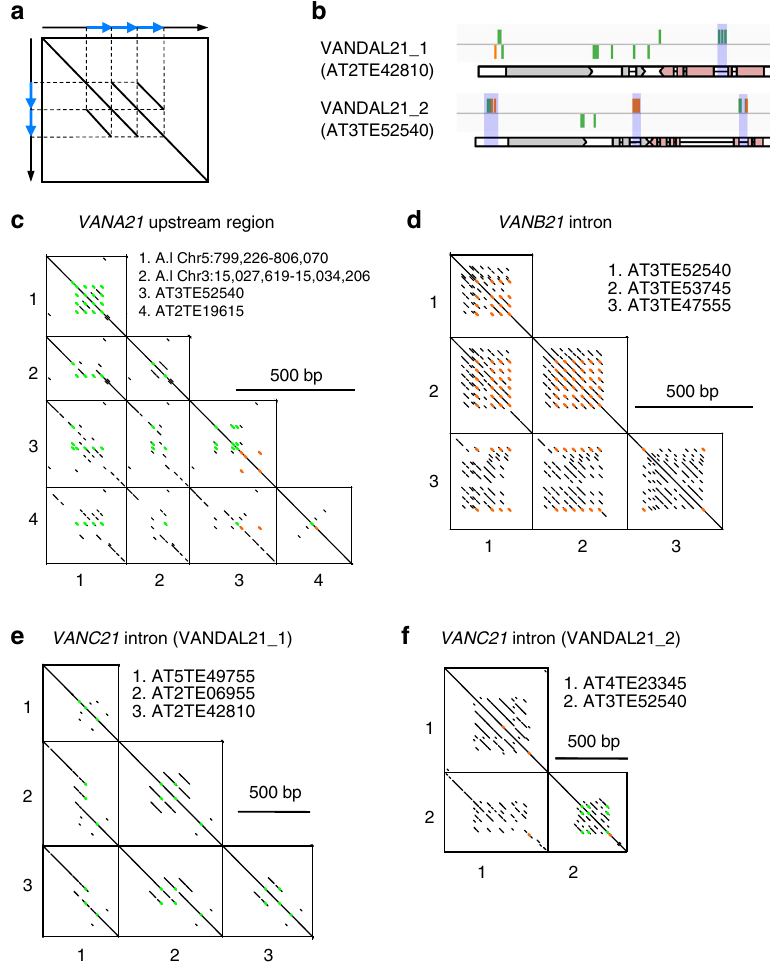
Fig. 4 Evolution of VANC21-binding regions. a Schematic diagram of dot plot for sequences with tandem repeat structures. Blue arrows indicate tandem repeats. Because of sequence identity, tandem repeat structure generates parallel lines. Difference in copy number can also be detected; in this case, three and two repetitions for X - and Y -axes, respectively. b Structures of VANDAL21 copies, with regions analyzed in c – f shown with shadow. Green and orange bars show C-type and T-type motifs. c – f Dot plots comparing the VANDAL21 sequences upstream of VANA21 ( c ), VANB21 intron ( d ), and VANC21 intron ( e , f ). Regions with 10 bp exact match are shown by dots. Green and orange indicate regions with C- and T-type motifs, respectively. Sequence alignments in these tandem repeat regions are shown in Supplementary Fig.